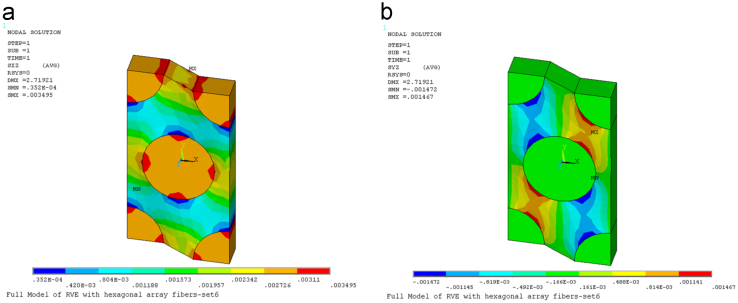
(a) Contour plot of stresses τxz on deformed RVE [TPa]. (b) Contour plot of stresses τyz on deformed RVE [TPa].